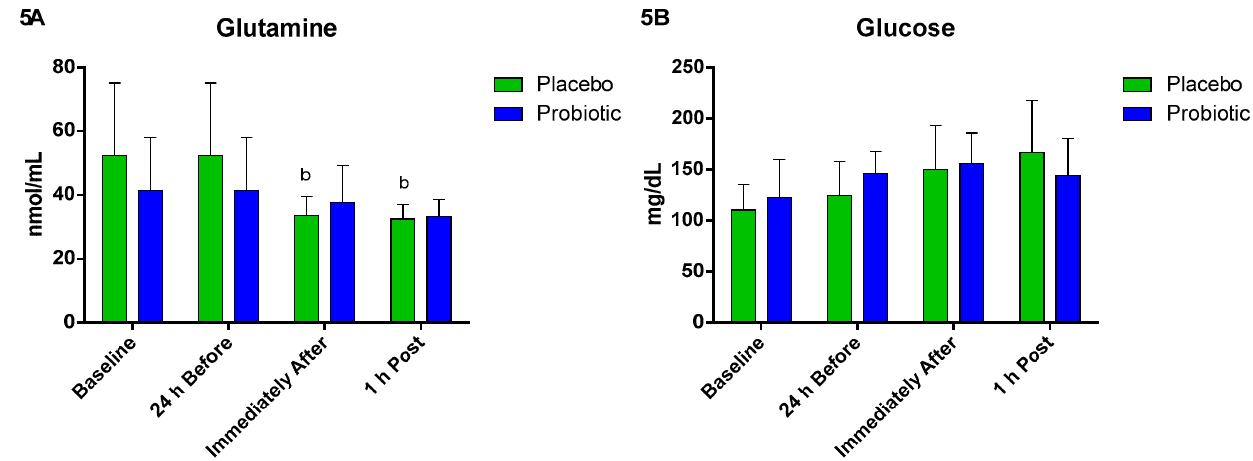
Figure 5. Plasma glutamine and glucose concentration. Data presented as mean ± standard deviation. Placebo ( n = 7) and probiotic ( n = 7). The comparison between groups and moments was performed through the general linear model (GLM) with post hoc Tukey. ( A ) Glutamine concentration. ( B ) Glucose concentration. b: differs from the ‘24 h Before’ of the same group.